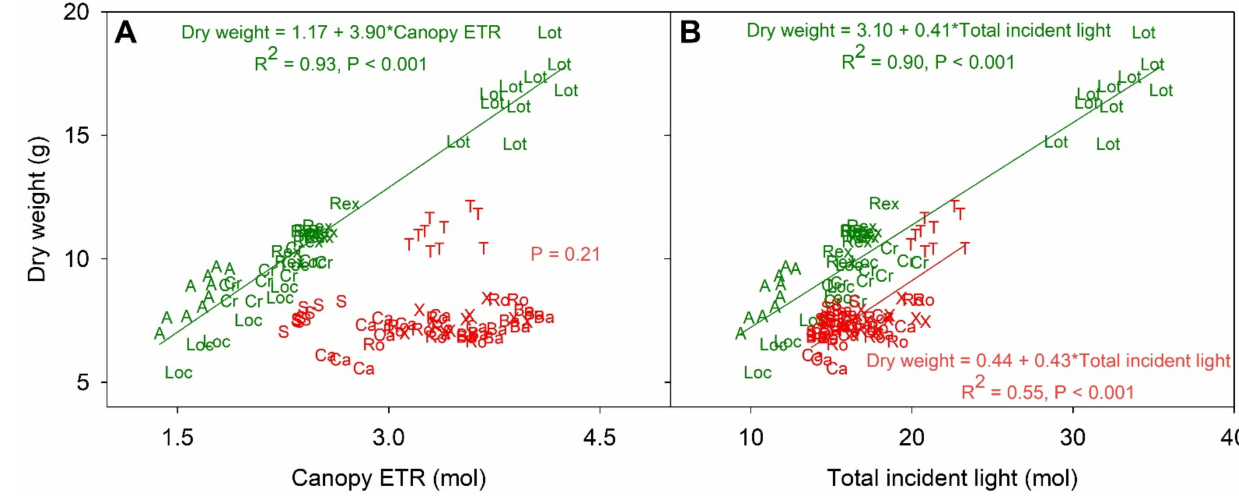
Figure 5. The relationship between estimated canopy electron transport rate (ETR) over the entire crop cycle ( A ) and total incident light with shoot dry weight at the harvest (DW) ( B ). Letters and their colors on the figures correspond to the red and green cultivars (‘Aquino’ (A), ‘Barlach’ (Ba), ‘Carmessi’ (Ca), ‘Crunchita’ (Cr), ‘Locarno’ (Loc), ‘Lotus’ (Lot), ‘Rex’ (Rex), ‘Rouxai’ (Ro), ‘Seurat’ (S), ‘Teodore’ (T), and ‘Xandra’ (X)). The regression equation (when significant) and p -value are shown in green and red text for the green and red cultivars.